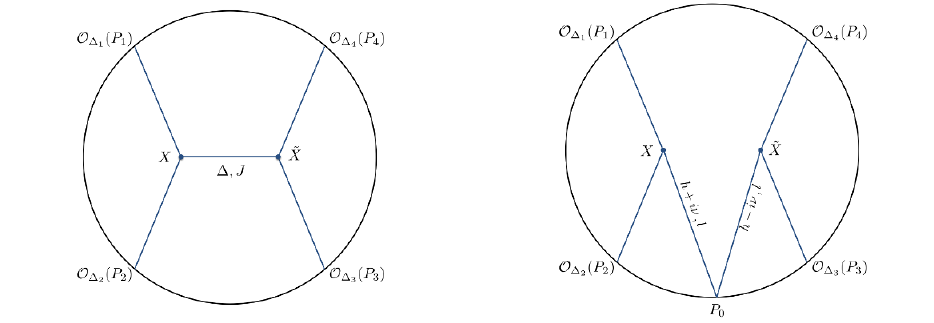
Figure 4 . Left: normal exchange Witten diagram with four scalar external (cid:12)elds and a spin- J internal (cid:12)eld, Right: a split